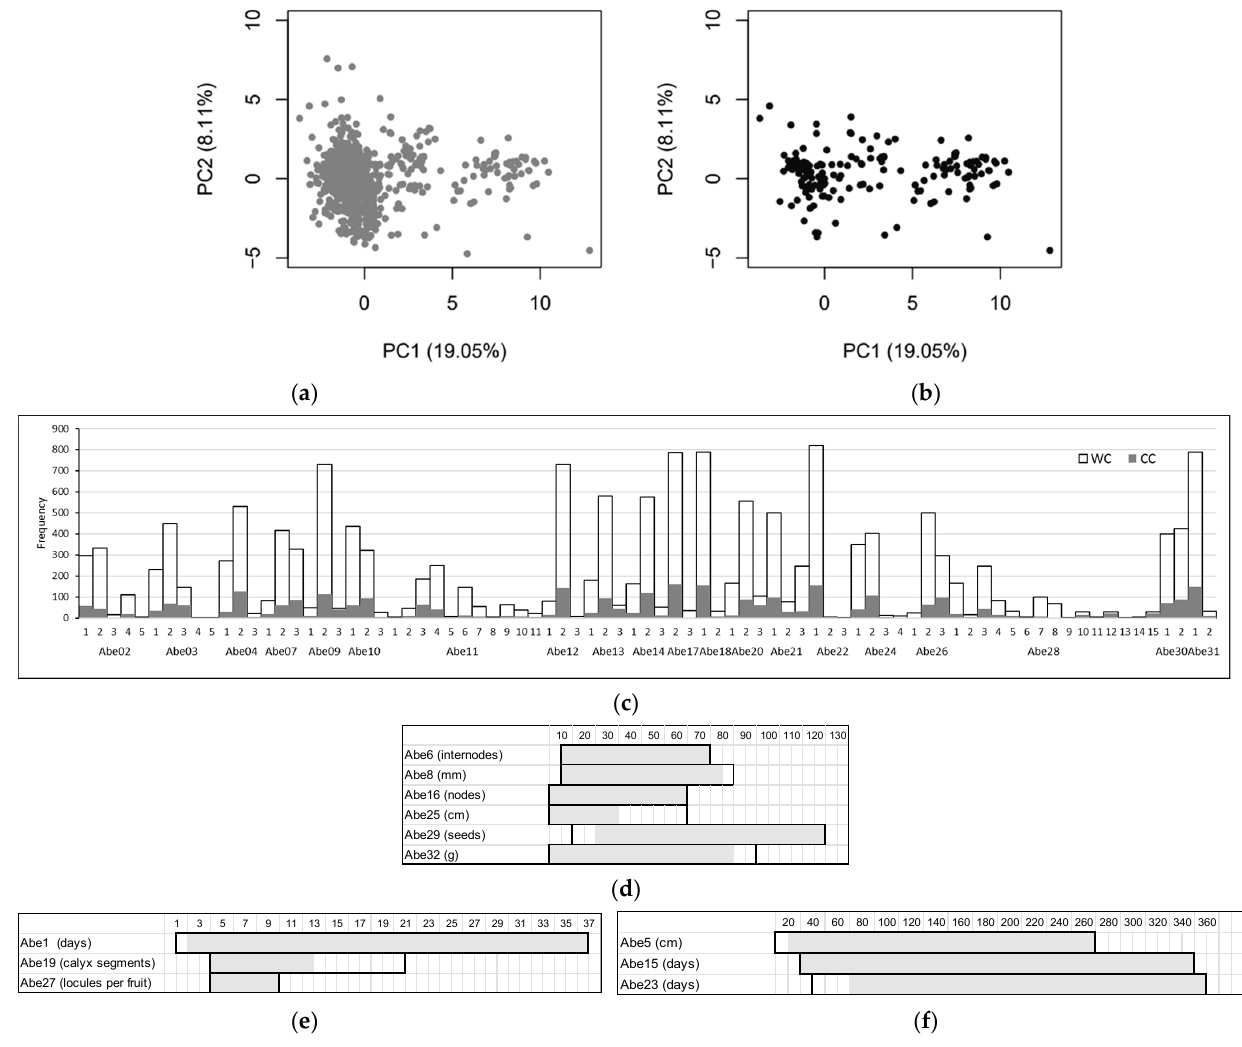
Figure 2. ( a ) Principal Component Analysis (PCA) of 32 quantitative and morphological descriptors in the whole collection and ( b ) in the core collection. ( c ) Analysis of categorical data in the whole collection (white bars) and the core collection (black bars). ( d – f ) Comparison of the range of quantitative data in the whole collection (boxes) and the core collection (shaded bars).